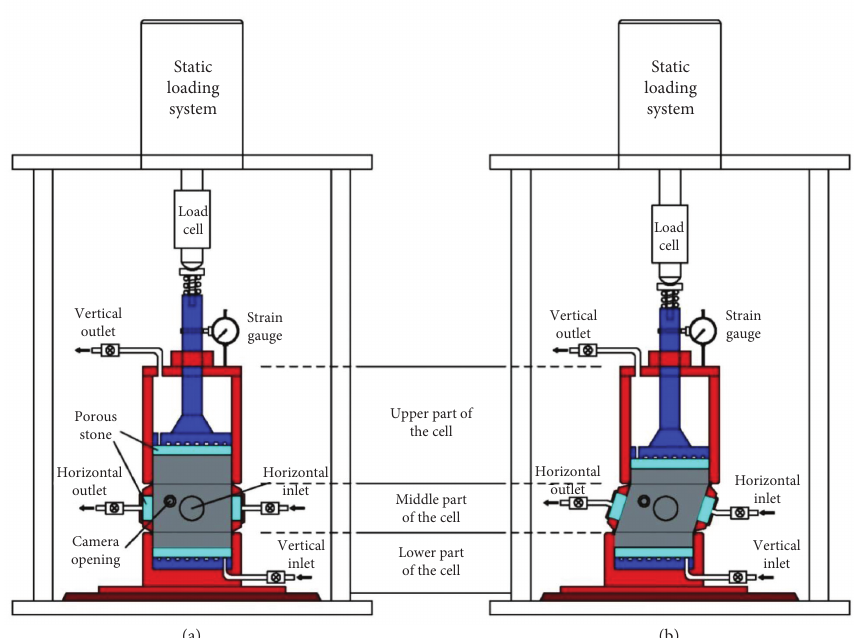
Figure 3: The layout of the test apparatus; (a) compression deformation of the soil sample and (b) simple shear deformation of the soil